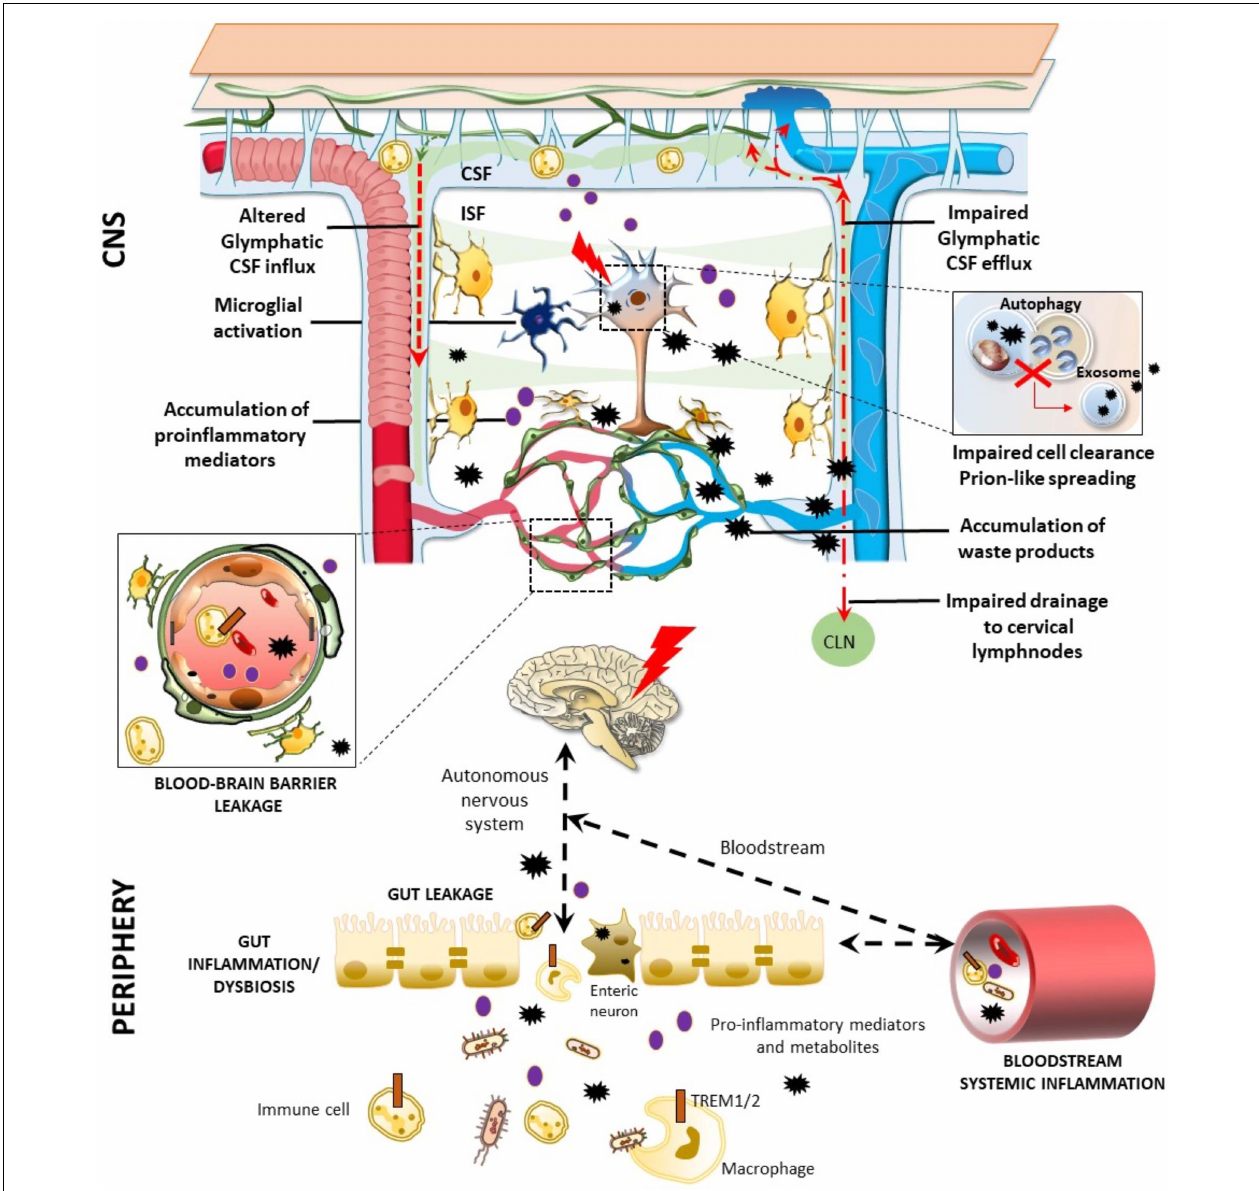
FIGURE 2 | Glymphatic pathway in pathological conditions: a role for the bidirectional gut-brain communication. Alterations of the glymphatic pathway may contribute to the extracellular accumulation of waste products, including altered protein in the brain (black stars). These include alterations in the morphology and drainage capacity of meningeal lymphatic vessels, impairment of CSF influx and efflux, along with the release of several pro-inflammatory cytokines and immune cells. Considering the reciprocal communication which occurs between the brain and the gastrointestinal tract, gut alterations can affect the CNS, and vice-versa. Potentially harmful solutes, including misfolded/aggregated proteins, may spread to the gut through the autonomic nervous system to induce inflammation [brain-first (top-down) type]. In turn, gut dysbiosis, inflammation, and leakage may promote the antidromic spread of potentially harmful molecules to the CNS via the vagal fibers or the bloodstream [body-first (bottom-up) type], bypassing and altering the glymphatic system and the BBB (left insert). These include misfolded/aggregated proteins such as α -synuclein, microorganisms, and also pro-inflammatory cytokines and activated immune cells, such as TREM TREM cells-positive activated macrophages. Extracellular accumulation of waste products related to an altered glymphatic drainage is exacerbated when intracellular clearing systems are impaired (right insert). This is the case of the autophagy pathway, which grants neuronal proteostasis and survival. When autophagy is impaired, extracellular release of undigested, potentially harmful substrates may occur via exosome